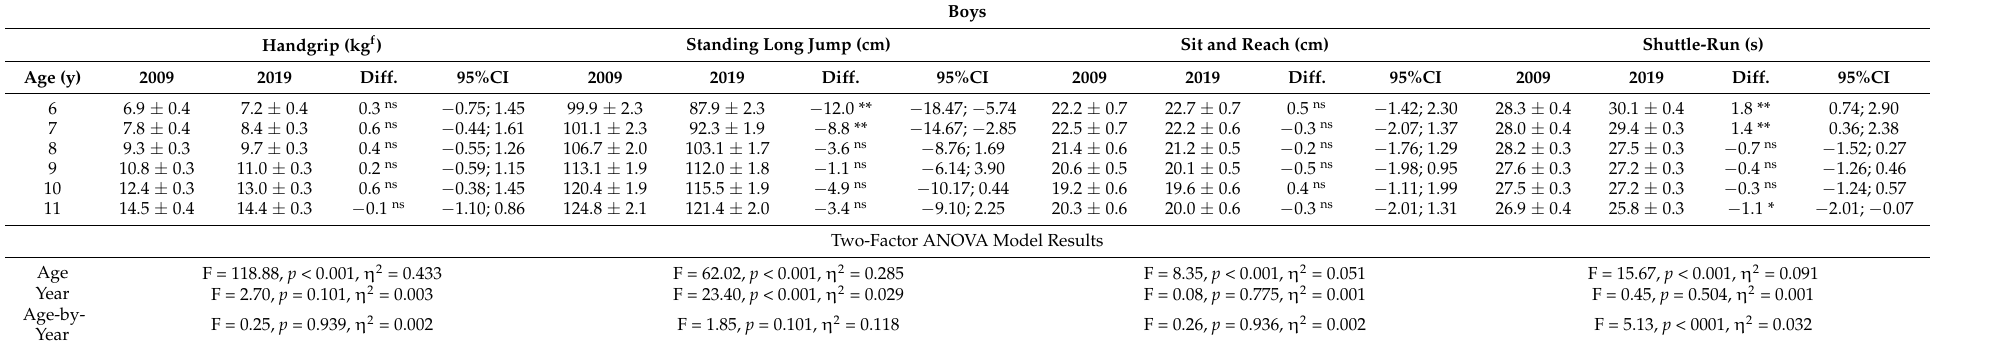
Table 4. Descriptive statistics (means ± standard errors), differences (diff) and their corresponding 95% confidence intervals (95%CI) for each physical fitness test in boys between 2009 and 2019